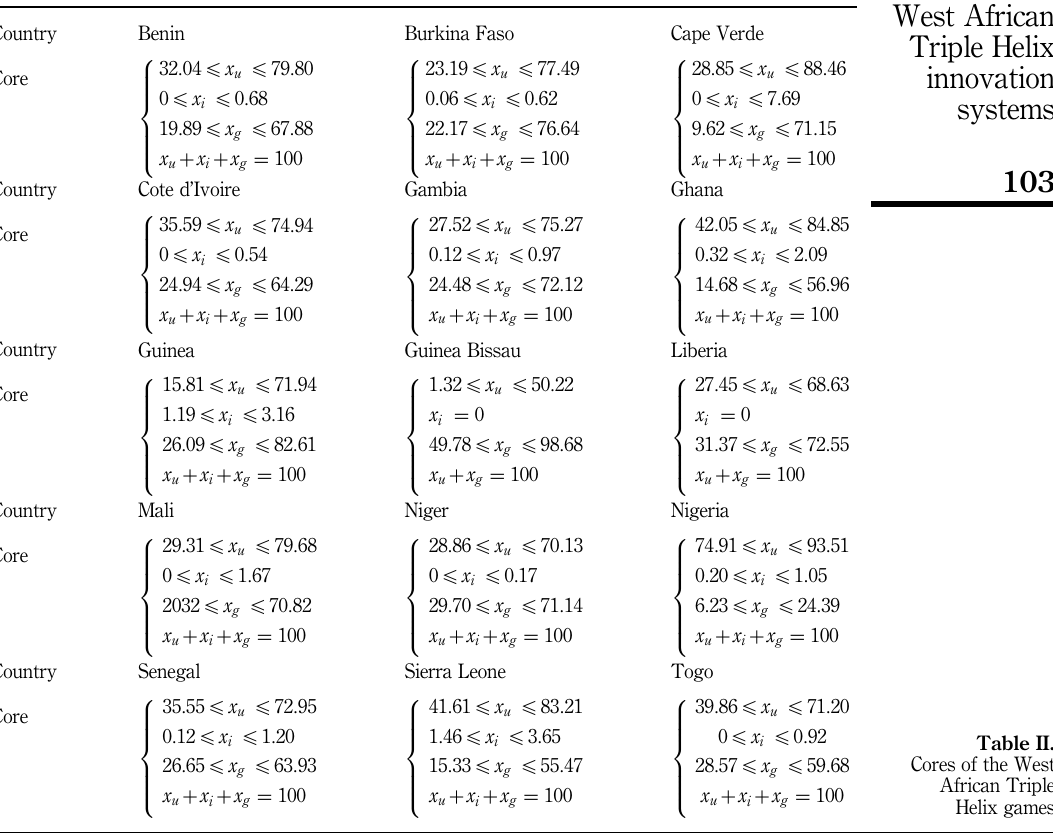
Table II. Cores of the